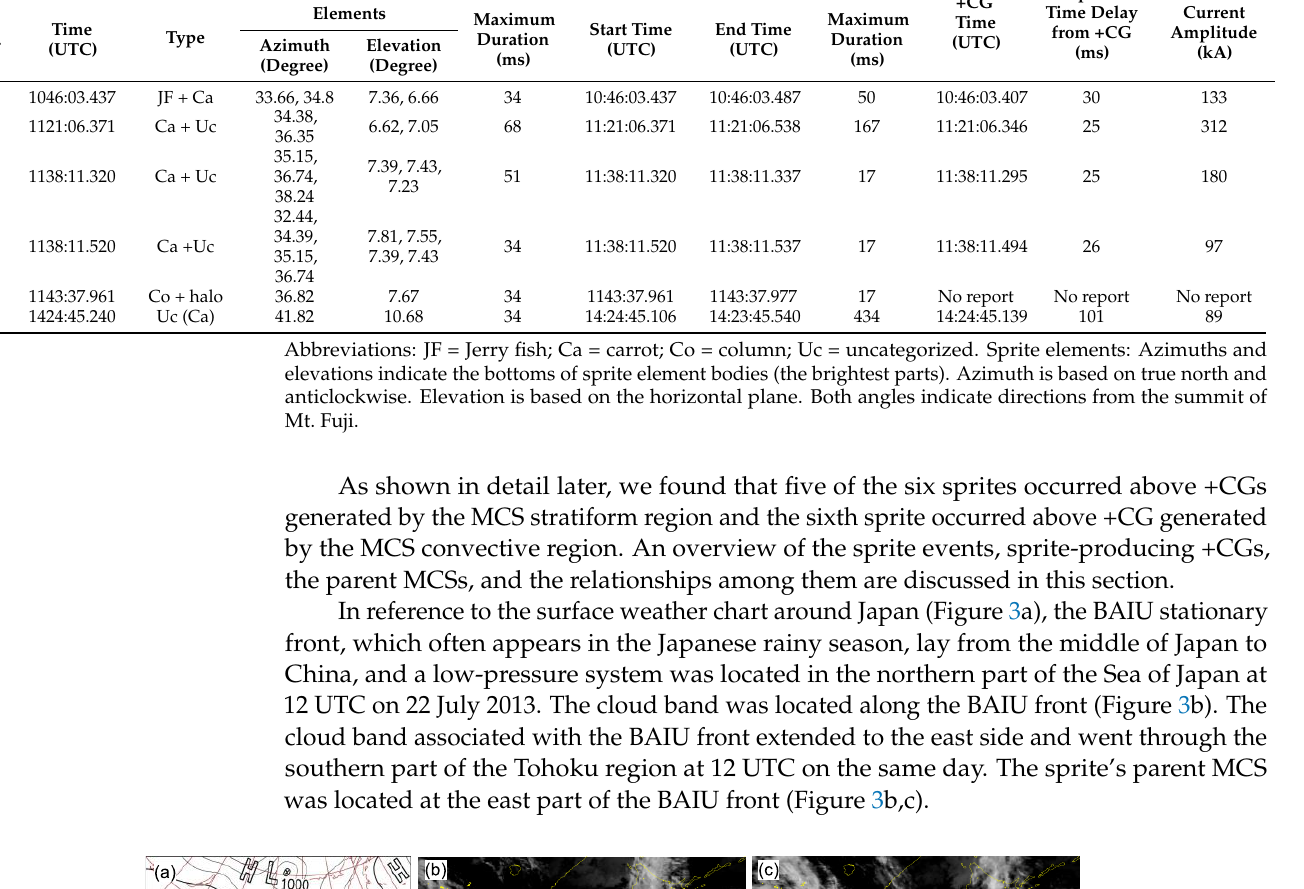
Table 1. Properties of sprites and optical cloud flash observed from the summit of Mt. Fuji and sprite-producing +CGs on 22 July 2013. Sprite Optical Cloud Flash